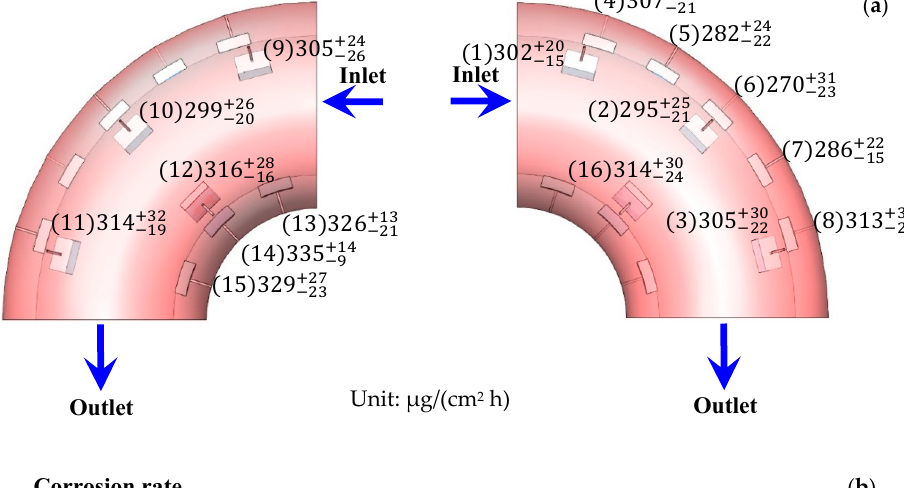
Figure 2. ( a ) Distribution of the total erosion–corrosion (E-C) rate after the E-C test; ( b ) contours of the total E-C rate after the E-C test; ( c ) distribution of the total corrosion rate after the E-C test; ( d ) contours of the total corrosion rate after the E-C test.